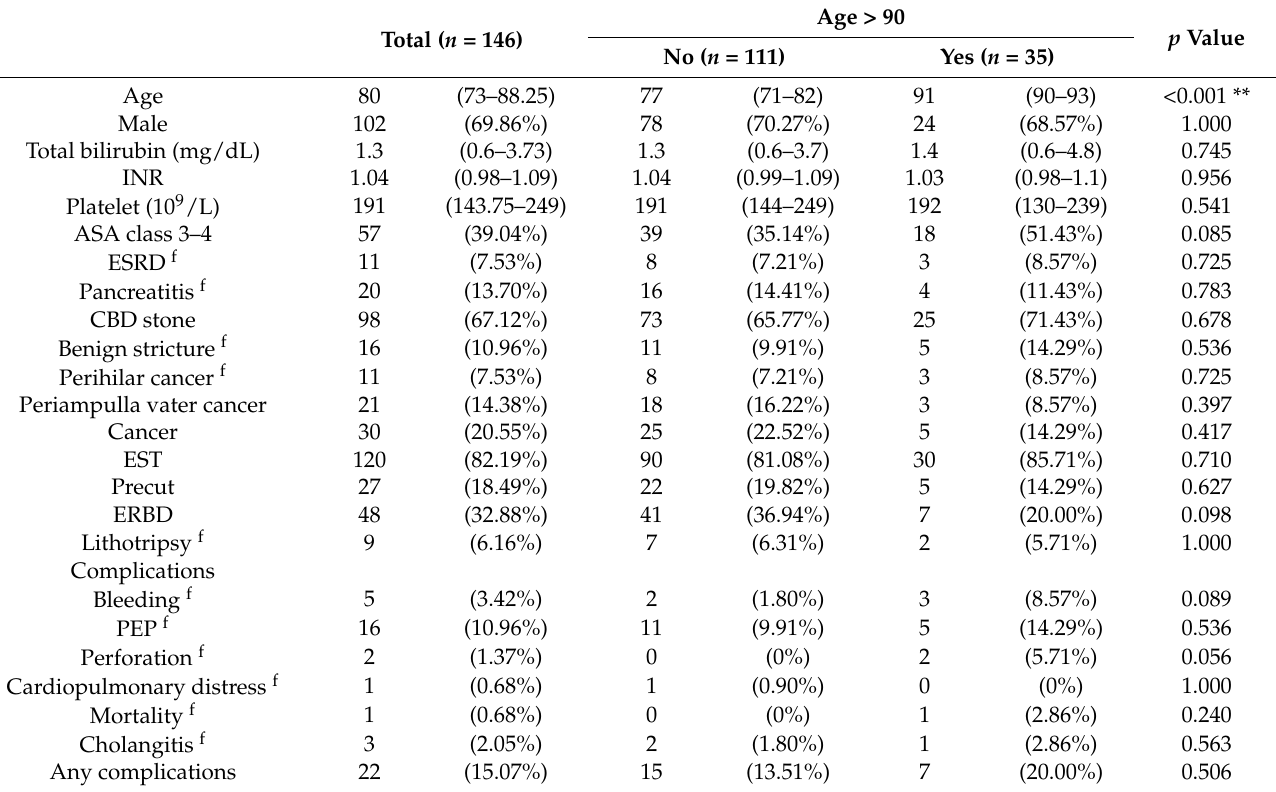
Table 1. Summary of patient characteristics in the nonagenarians and control group (aged